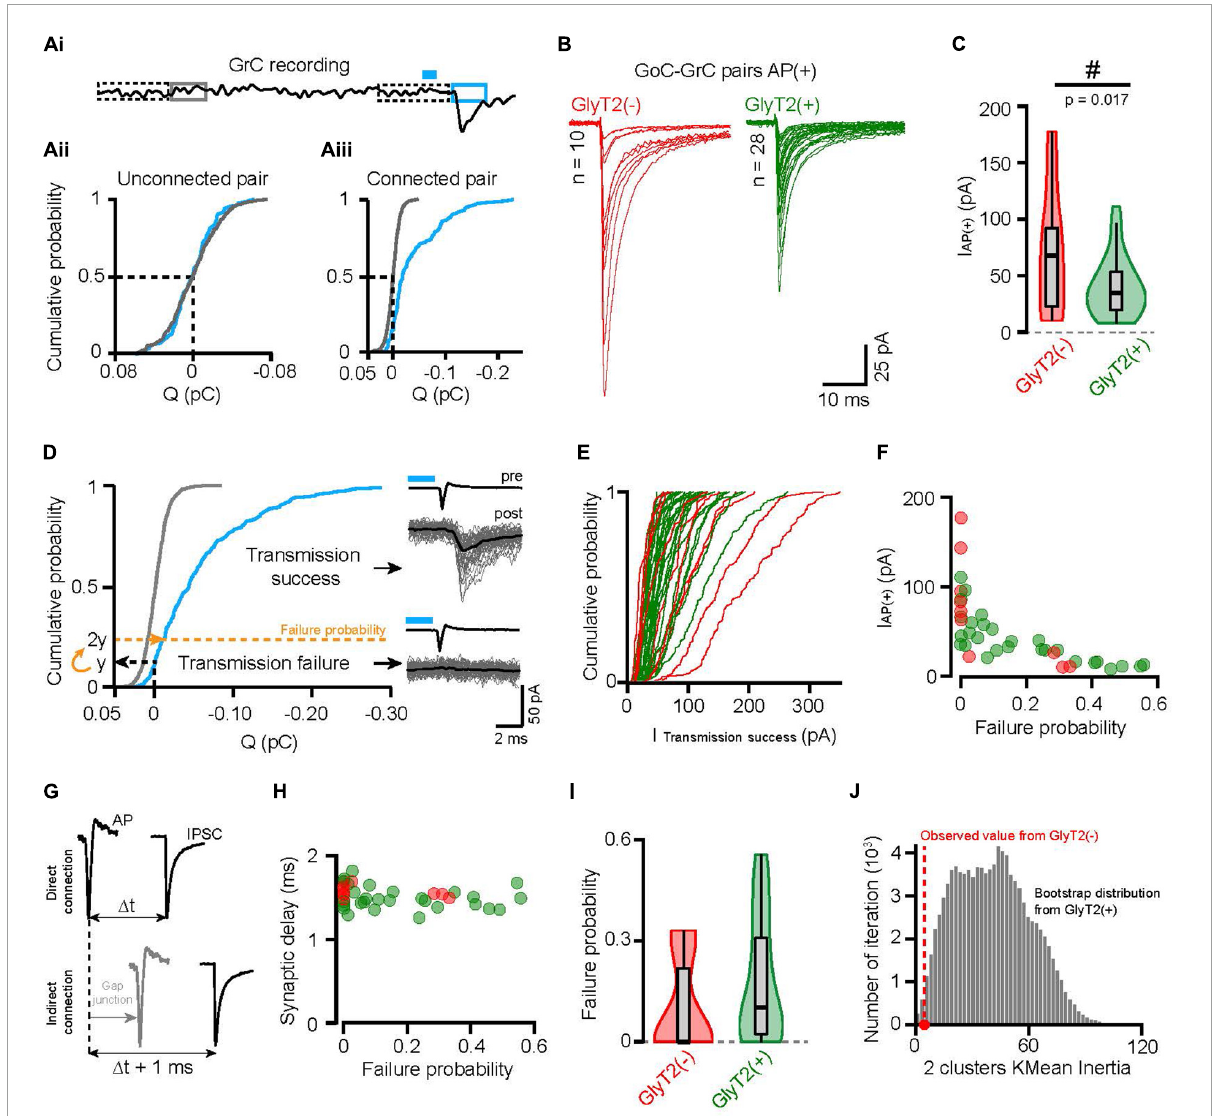
FIGURE3 GlyT2(–) and GlyT2(+) GoC-GrC connections have different synaptic properties. (Ai) Illustration of the charge measurement in GrCs recordings before (gray) and after optogenetic stimulation evoking GoCs AP (blue) . Dotted rectangles represent the local 10 ms normalization windows (see materials and method). (Aii) Cumulative probability distribution of the baseline (gray) and post-AP (blue) charges from a representative unconnected pair. (Aiii) Same as panel (Aii) for a representative connected pair. (B) Average GrCs traces following optogenetically evoked AP in GyT2(–) (red, n = 10) and GlyT2(+) (green, n = 28) GoCs. These traces will be referred as AP(+) from here and I AP ( + ) is the peak amplitude of the averaged AP(+) traces. (C) Violin plot distribution of I AP ( + ) of GlyT2(–) and GlyT2(+) pairs shown in panel (B) . The “#” symbolized the significative result from the Conover test of variance. (D) Same representation as panels (Aii, Aiii) , showing the transmission failure threshold of a representative connected pair (dotted yellow line). Right insert, resulting classification of the example traces in transmission success or failure with the corresponding average (black) . (E) Cumulative distribution probability of the transmission success peak amplitude for each GoC-GrC pairs. These curves show that GlyT2(–) pairs are more right shifted than the GlyT2(+) ones, but no significant differences emerge with this metric cleaned of transmission failure [GlyT2(–): 80.78 ± 51.75 pA, n = 10; GlyT2(+): 53.94 ± 23.75 pA, n = 28; p = 0.3]. (F) Transmission failure probability in function of the I AP ( + ) for all connected pairs ( n = 38). (G) Schematic illustrating the consequence of indirect GoC-GrC connection through Gap junction on the synaptic delay. (H) Transmission failure probability in function of the synaptic delay (peak-to-peak time between AP and I AP ( + ) ; GlyT2(–): 1.57 ± 0.072 ms, n = 10; GlyT2(+): 1.49 ± 0.133 ms, n = 28; p = 0.04). (I) Violin plot distribution of failure probability showing a bimodal distribution for GlyT2(–) GoCs pairs and a continue one for GlyT2(+) ones. (J) Histogram of the inertia for 2 clusters K -mean analysis on bootstrap distribution of GlyT2(+) failure probability distribution (green) . The red dot is the inertia of GlyT2(–) 2 clusters K -mean analysis on the distribution shown in panel (I) . This figure shows how likely 8 points draw randomly with replace from the GlyT2(+) distribution give rise to a distribution as separated as the GlyT2(–)